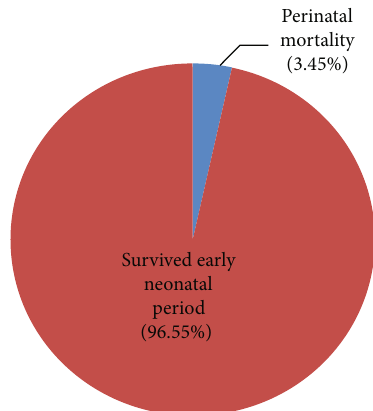
Figure 1: The magnitude of perinatal mortality in Jimma Zone, Southwest Ethiopia,